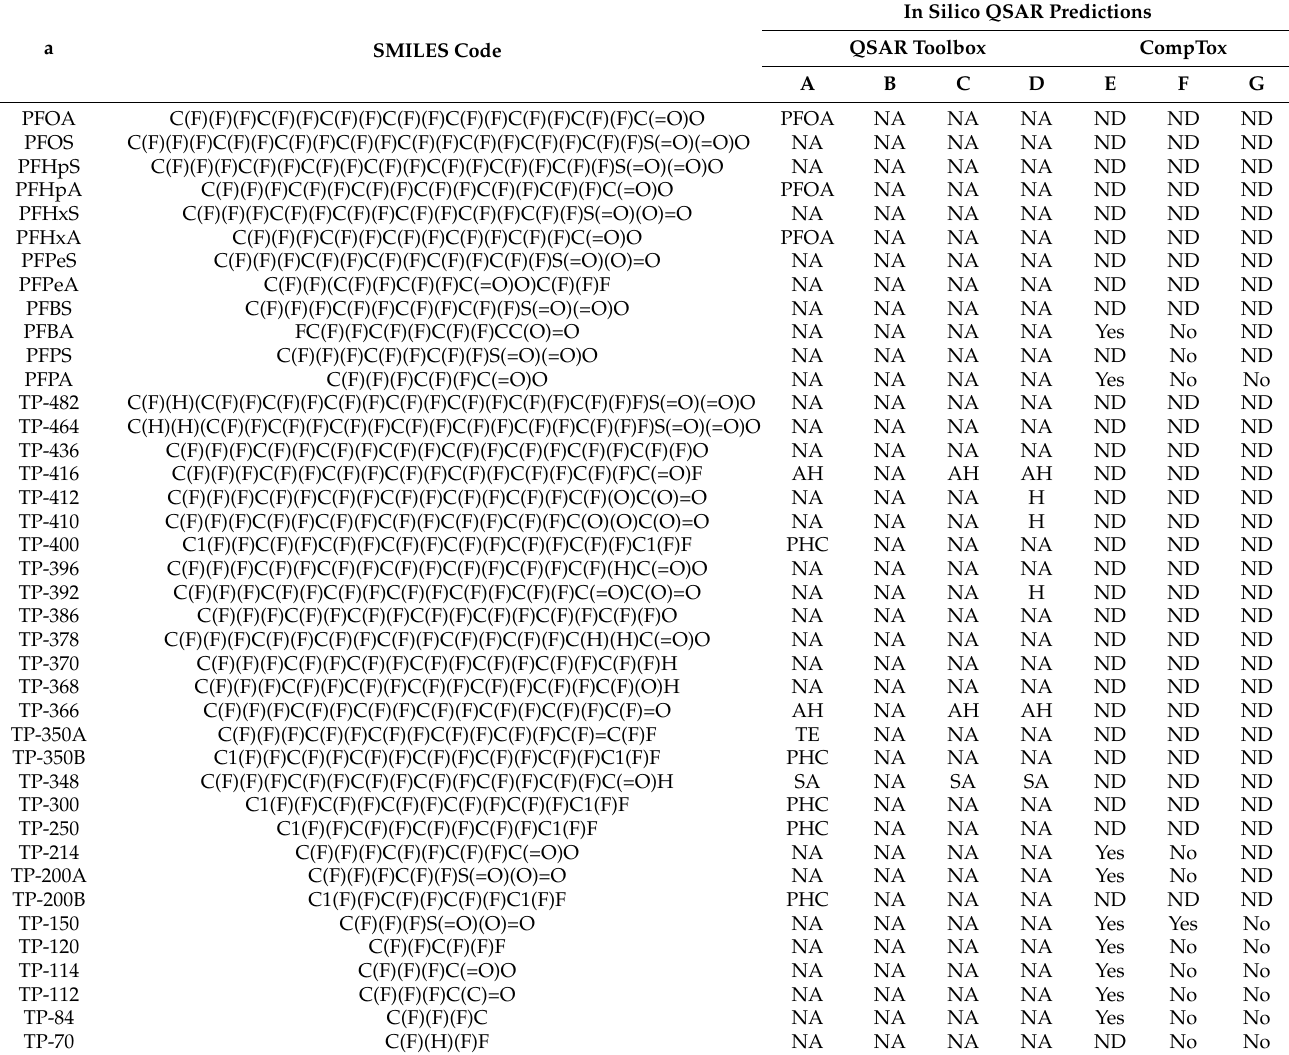
Table 3. The predicted multi-endpoint toxicity levels of PFOA, PFOS, and their TPs generated from the treatments using the electron beam and plasma